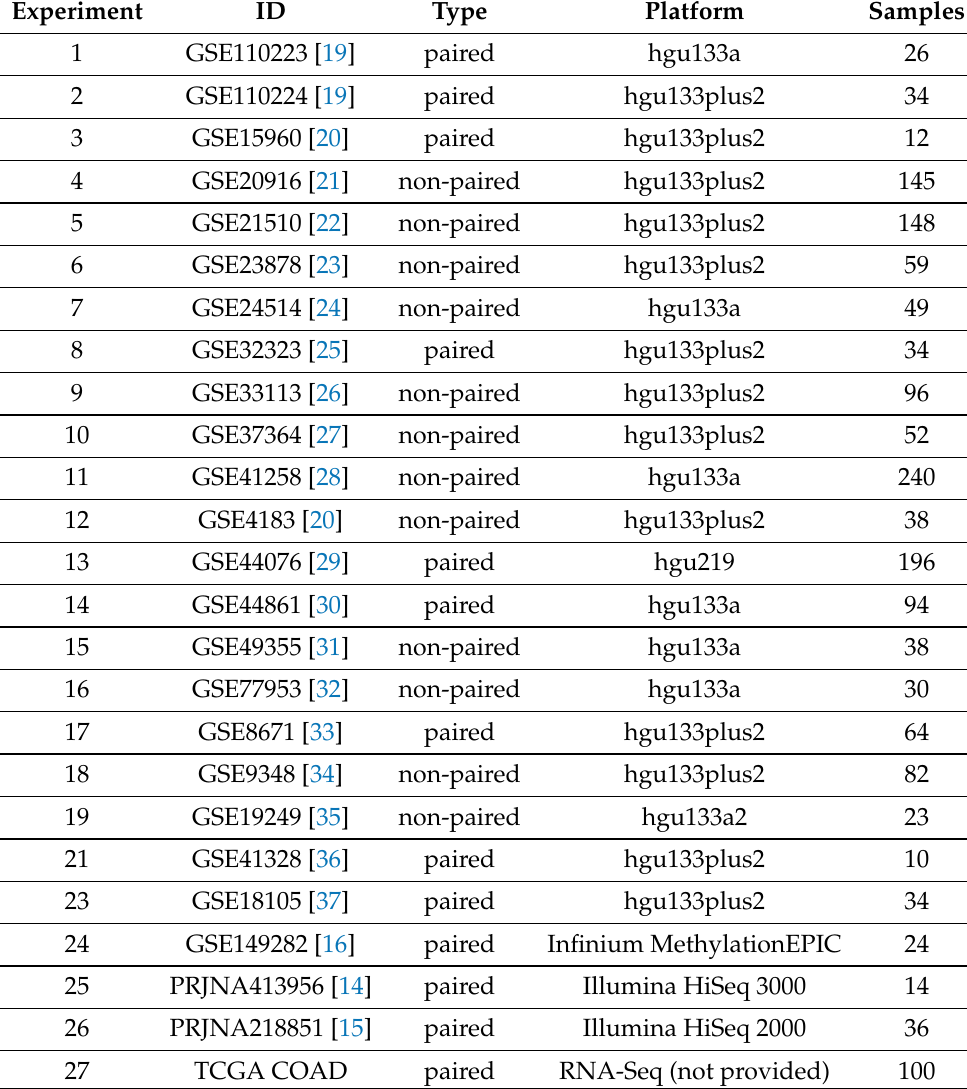
Table 1. Summary of datasets included in the analysis for testing the proposed